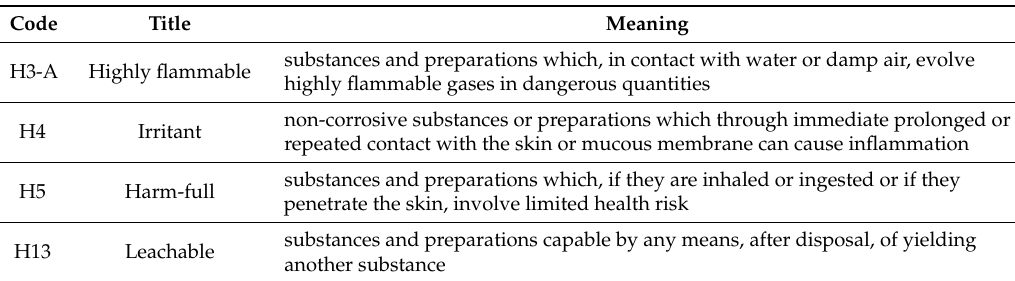
Table 4. Hazardous properties of aluminum salt slag according to the European waste catalogue and hazardous waste list. Data elaborated from